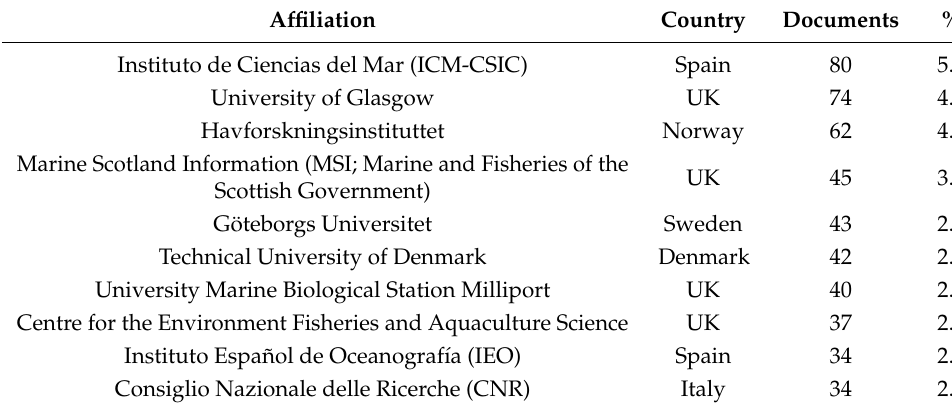
Table 1. Top 10 institutional affiliations of the papers’ co-authors and pertaining countries, plus the relative percentages out of the total (of all institutional affiliations for all retrieved papers).